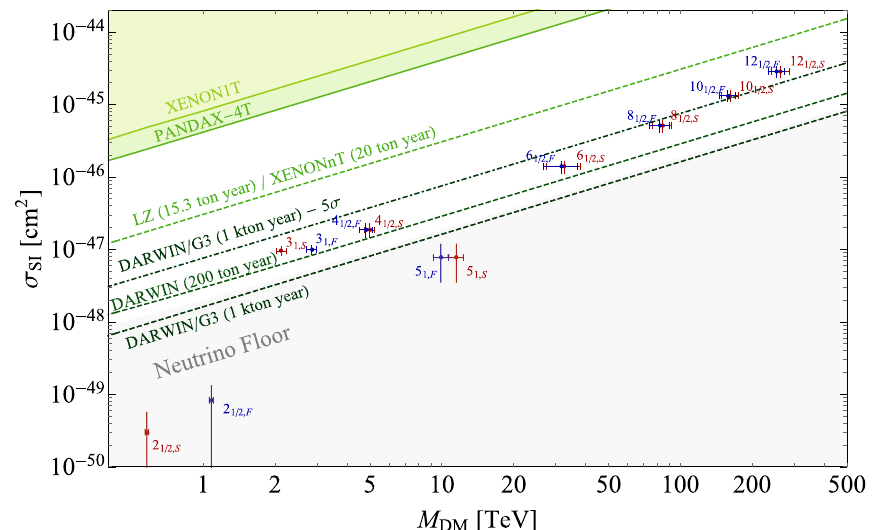
Fig. 3 Expected SI cross-sections for different complex WIMPs for minimal splitting as defined in Sect. 3. The blue dots correspond to Dirac WIMPs and the red dots to complex scalar WIMPs. The vertical error bands correspond to the propagation of LQCD uncertainties on the elastic cross-section (Eq. 18), while the horizontal error band comes